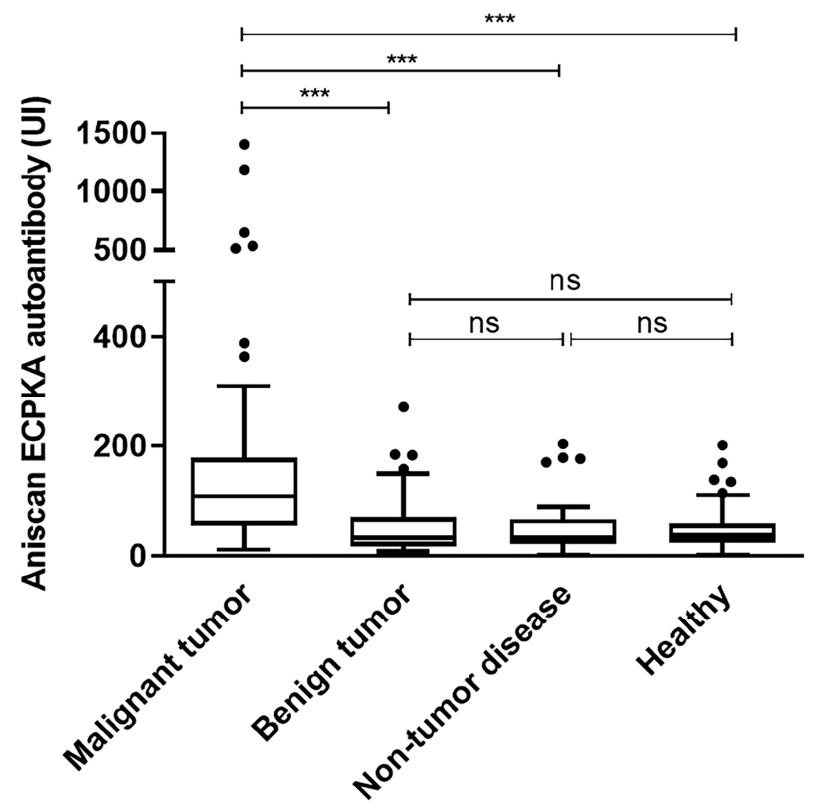
Figure 2. Box plot of AniScan ECPKA autoantibody levels in dogs with malignant tumors, benign tumors, and non-tumor disease and the healthy control group (*** p < 0.001 by one-way ANOVA